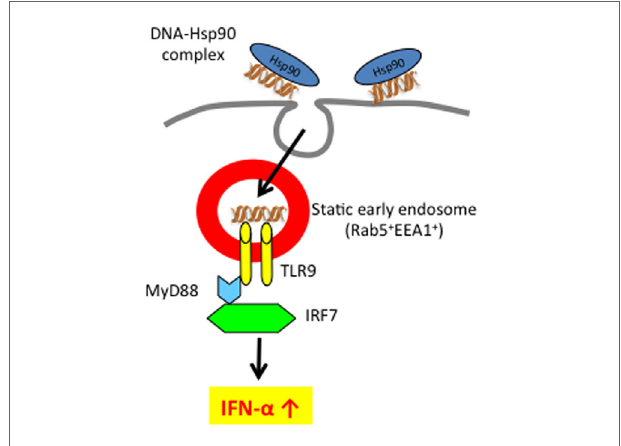
FiGURe 2 | extracellular self-DNA stimulates pDC to produce iFN- α when chaperoned by Hsp90 via spatiotemporal regulation . Hsp90–self- DNA complex found in SLE patient’s serum is targeted to pDCs and retained for longer periods within early static endosome via action of Hsp90, leading to production of IFN- α